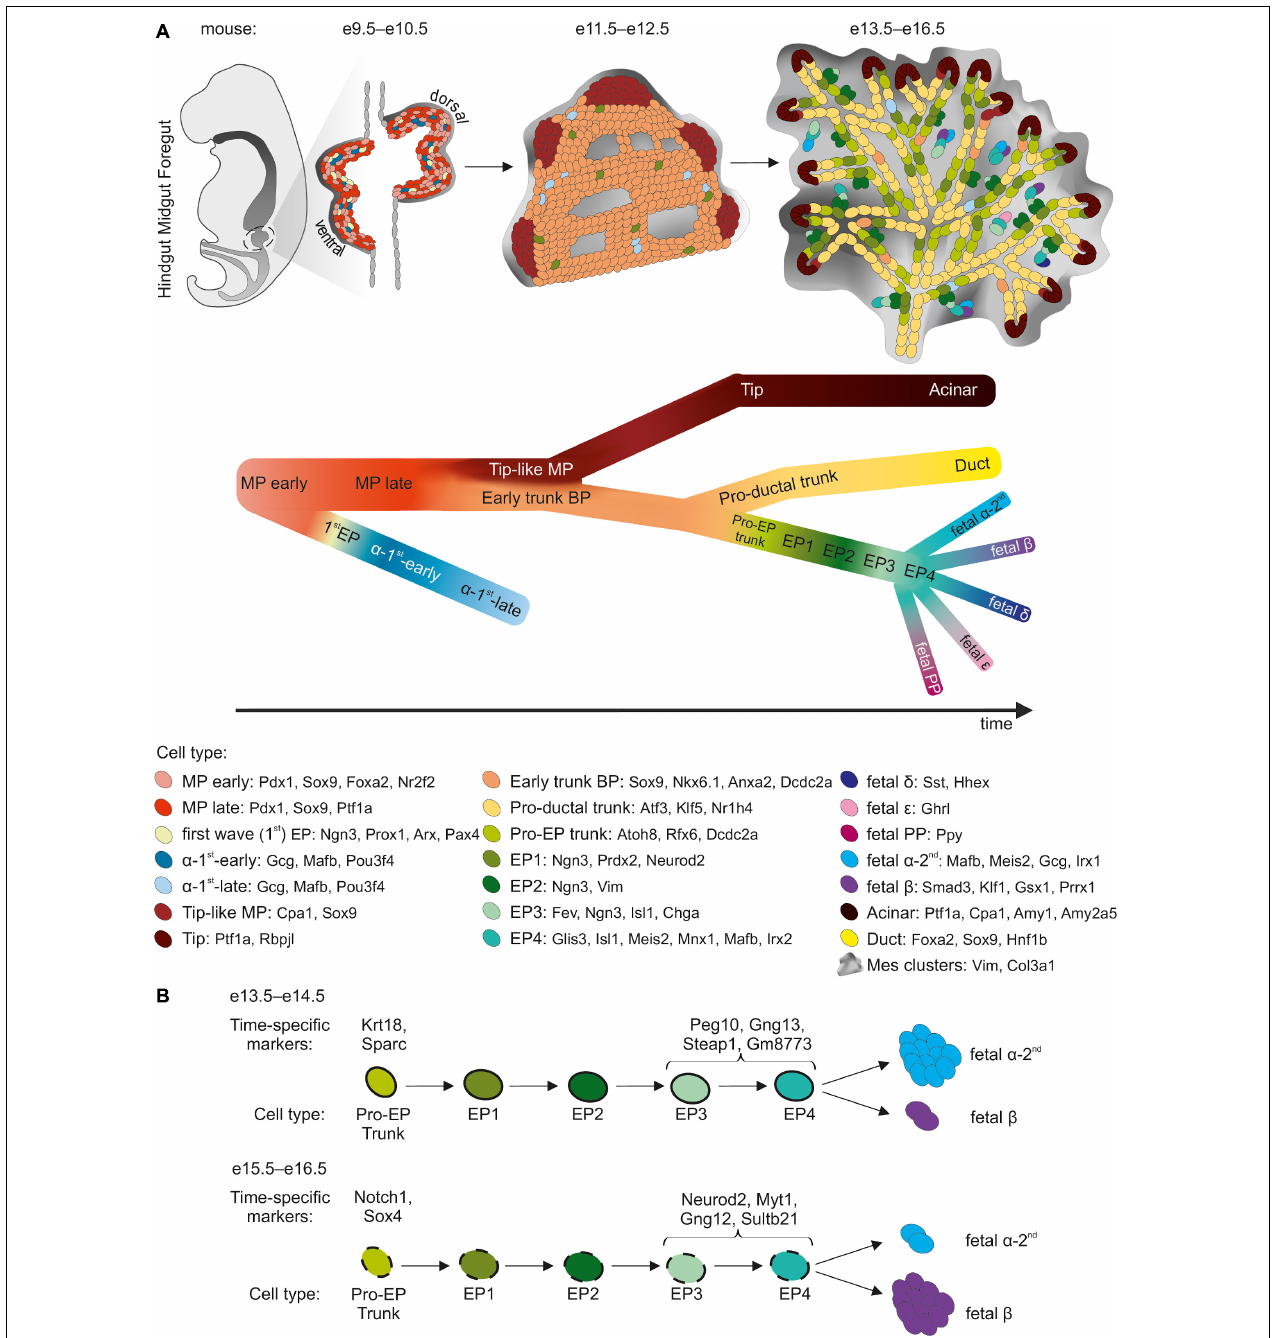
FIGURE 1 | sc-RNA-Seq insight into murine pancreatic development. (A) Three major morphogenesis transitions in pancreatic development are shown. Cell types with cell specific markers are listed in the legend below. The black arrow indicates the developmental trajectory. MP, multipotent progenitors; BP, bipotent progenitors; EP, endocrine progenitors. (B) Developmental trajectory of Pro-EP trunk and EP cells as they differentiate at e13.5–e14.5 preferably into α -cells, and at e15.5–e16.5 preferably into β -cells. Time point-specific markers are listed above the scheme.